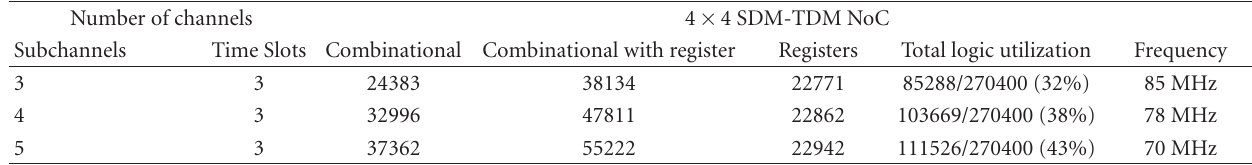
Table 8: Synthesis results 4 × 4 SDM-TDM based